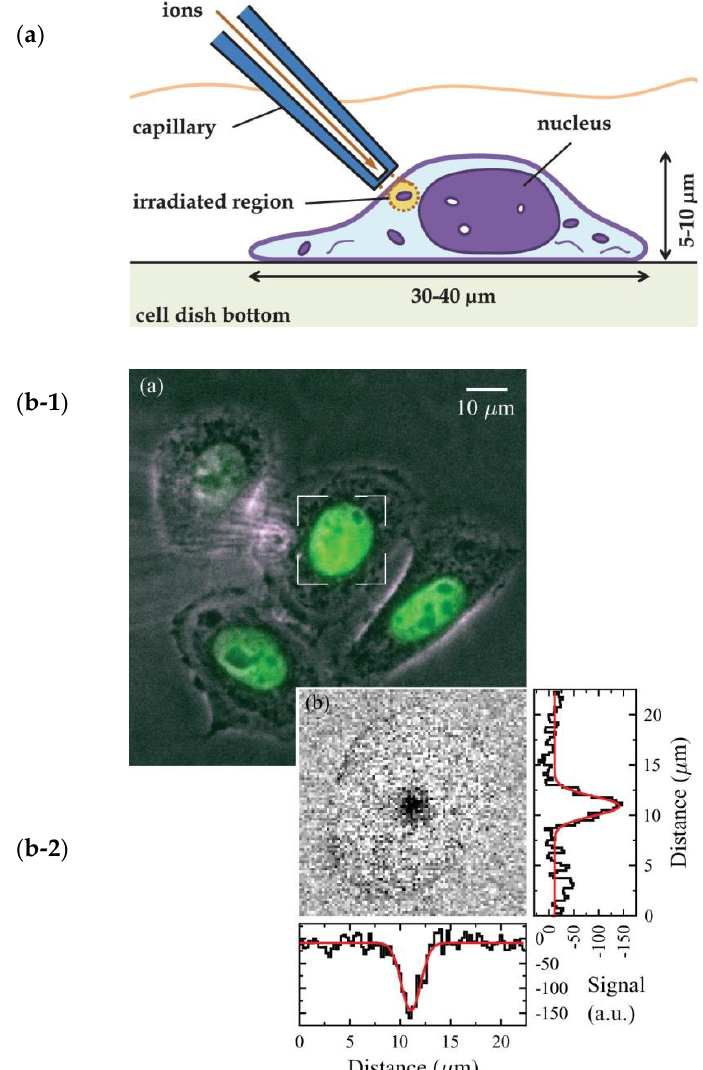
Figure 16. ( a ) A schematic drawing of the capillary-based micro-irradiation setup. After passing through the end window, ions irradiate a selected µ m 3 volume of the cell. ( b-1 ) HeLa cells together with the outlet of the capillary (left top). Shown is the merged phase contrast and fluorescence image. The capillary aims at the center of the cell nucleus marked by the white square. ( b-2 ) The irradiated region is visible as a dark spot. (Reprinted from [53], with the permission of AIP Publishing).